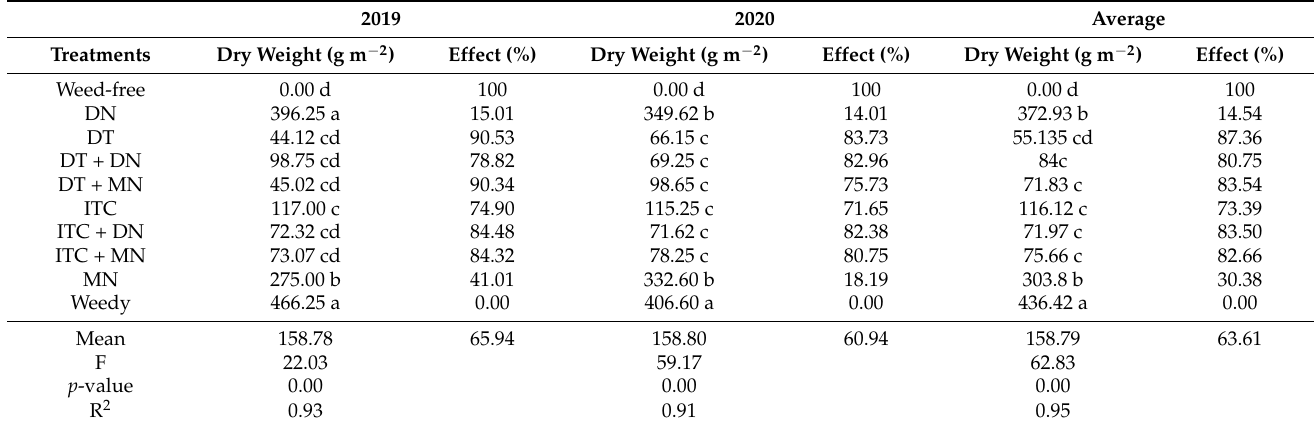
Table 6. Variance analysis and effects of treatments on weed dry